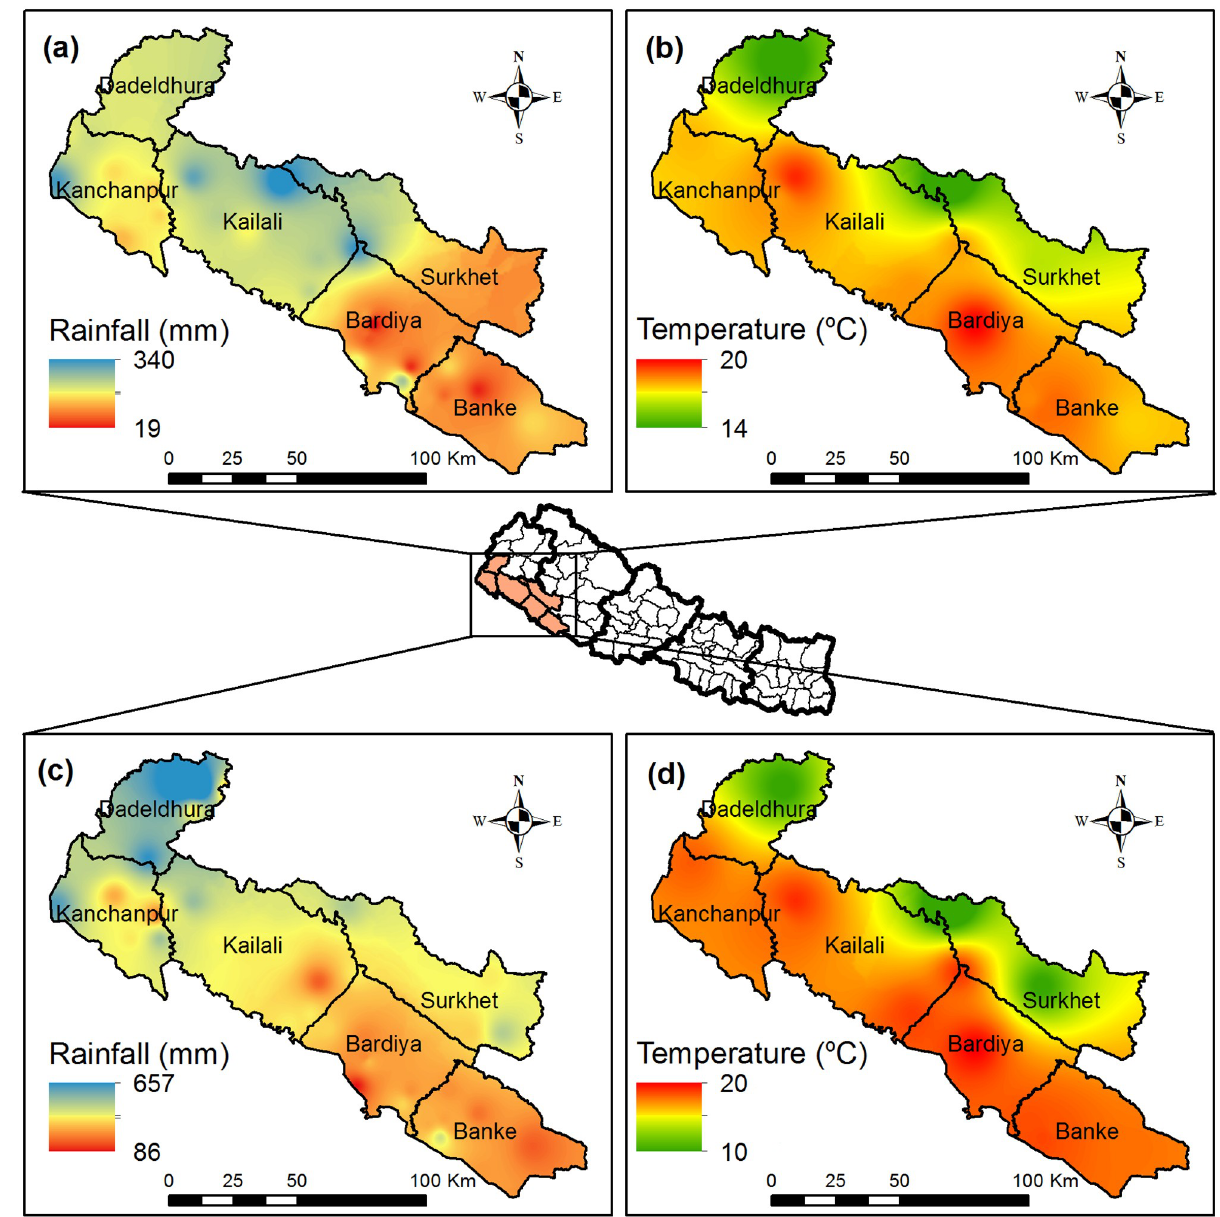
Fig 1. Within season and across year’s spatial variability in climatic parameters during lentil producing time (Oct–March) in study areas: a) rainfall in 2014, b) temperature in 2014, c) rainfall in 2015, and d) temperature in